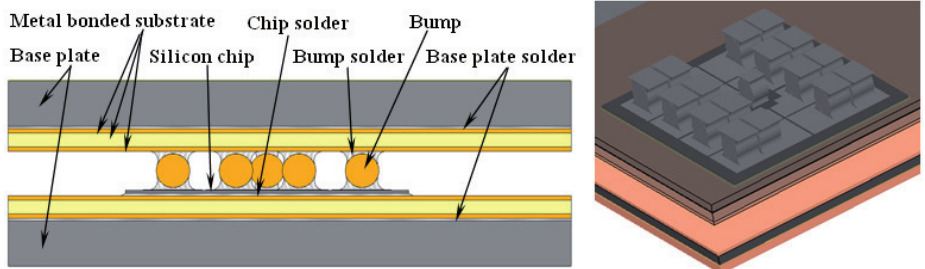
Fig. 9. Power Bump (PB) assembly (Infineon 1200 V – 150 A chip).